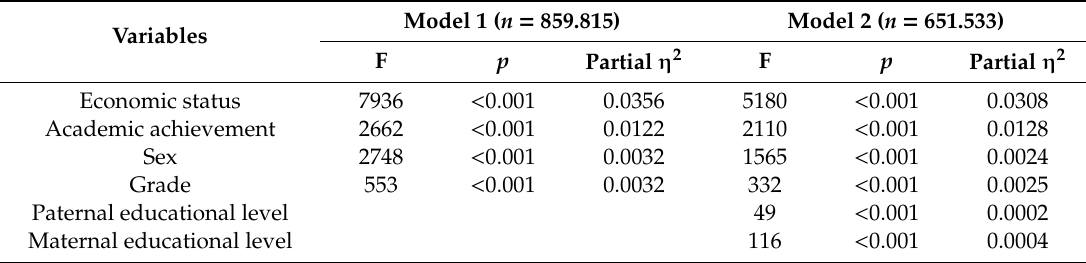
Table 2. Association between subjective happiness and the demographic variables.